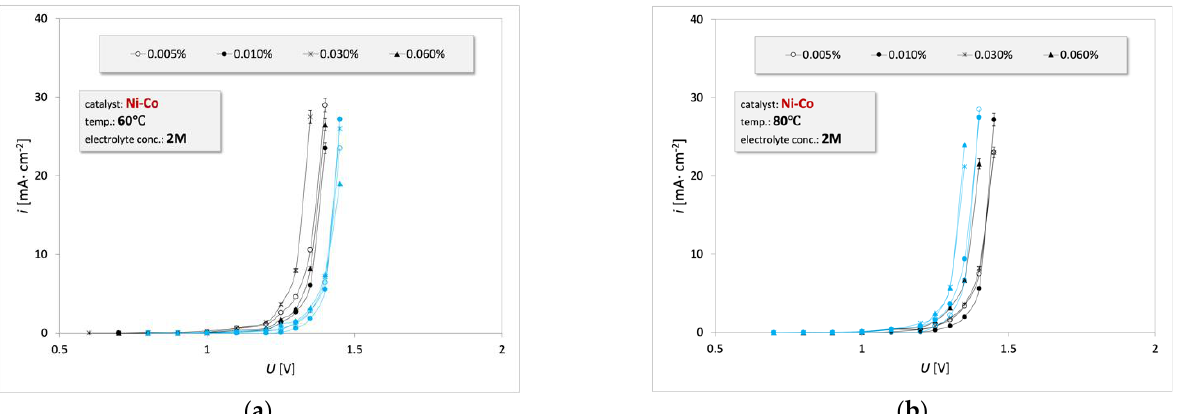
Figure 9. Electrooxidation curves of WEO emulsion (black lines) and detergent (blue lines) for various concentrations of detergent and emulsion on the Ni-Co catalyst for an electrolyte concentration of 2 M. Electrooxidation: ( a ) temperature: 60 °C; ( b ) temperature: 80 °C.